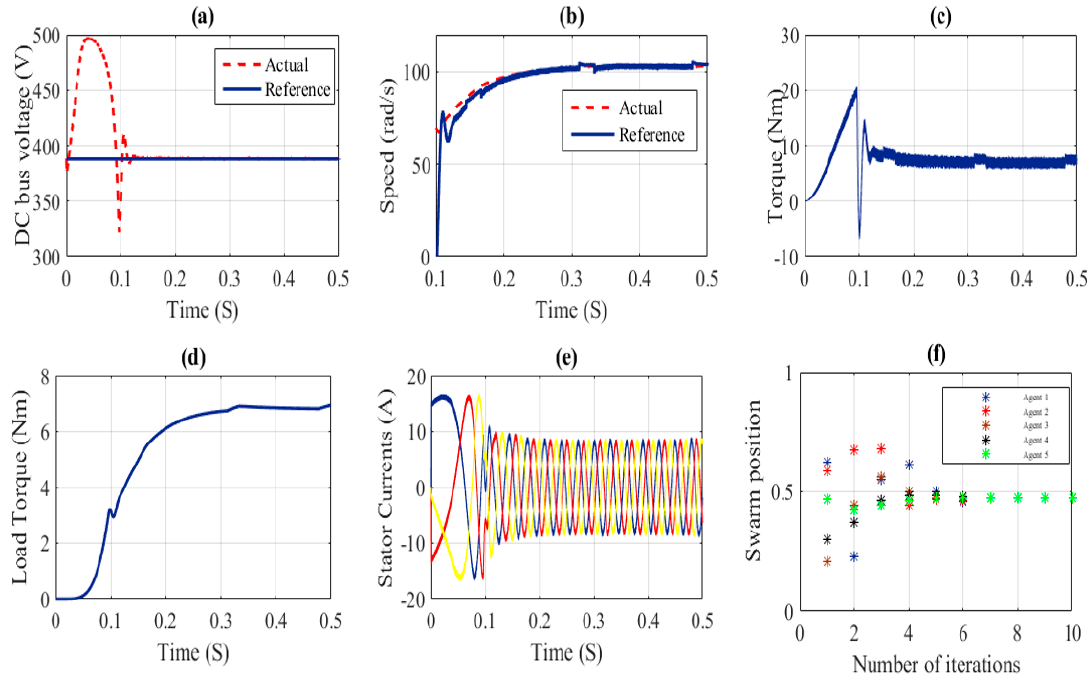
Figure 9. The detailed performance of solar photovoltaic water pumping system (SPVWP) system under first scenario using SSA based tracker. ( a ) Direct Current (DC) bus voltage; ( b ) motor speed; ( c ) electromagnetic torque; ( d ) load torque; ( e ) stator currents; ( f ) swarm position vs. number of iterations.